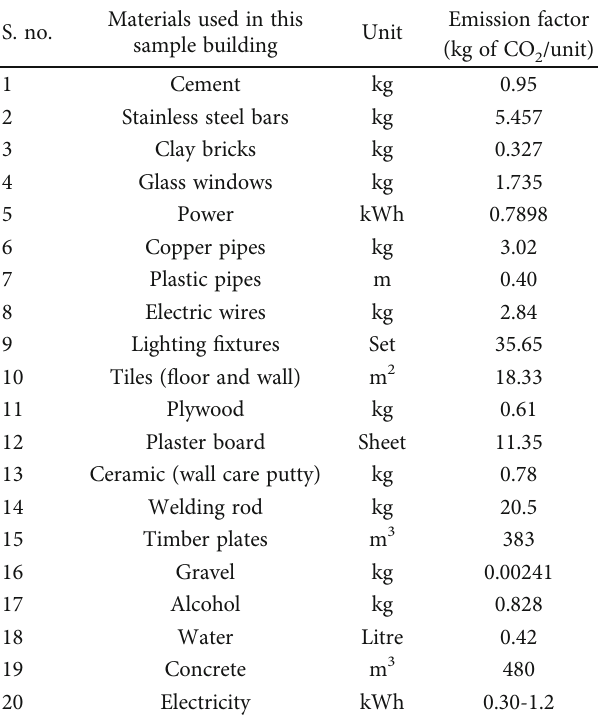
Table 1: Common materials used and emissions in residential buildings. S. no.